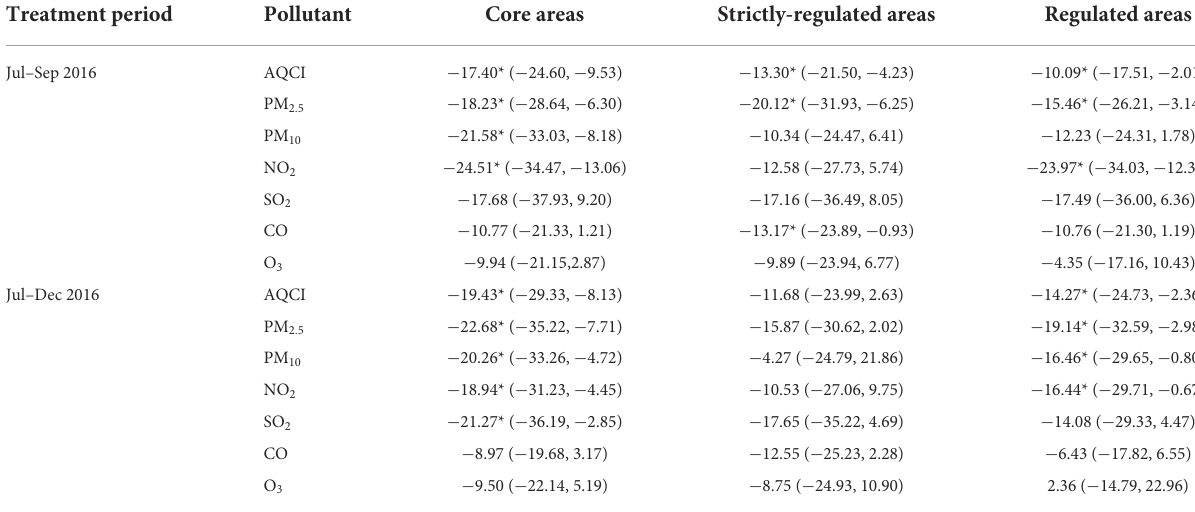
TABLE 1 The effect (ATT with 95% CI) of policy on AQCI and six main pollutants in three types of area. Treatment period Pollutant Core